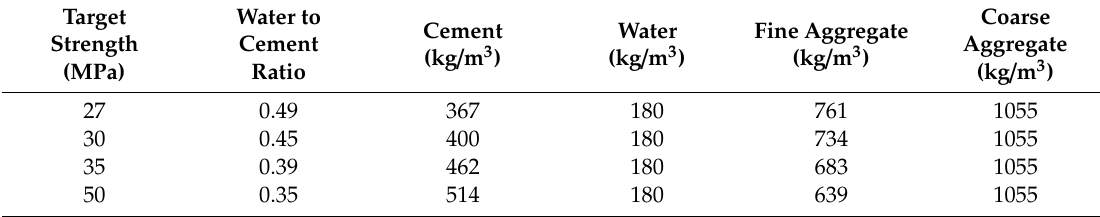
Table 2. Concrete mix proportions of various target strengths.